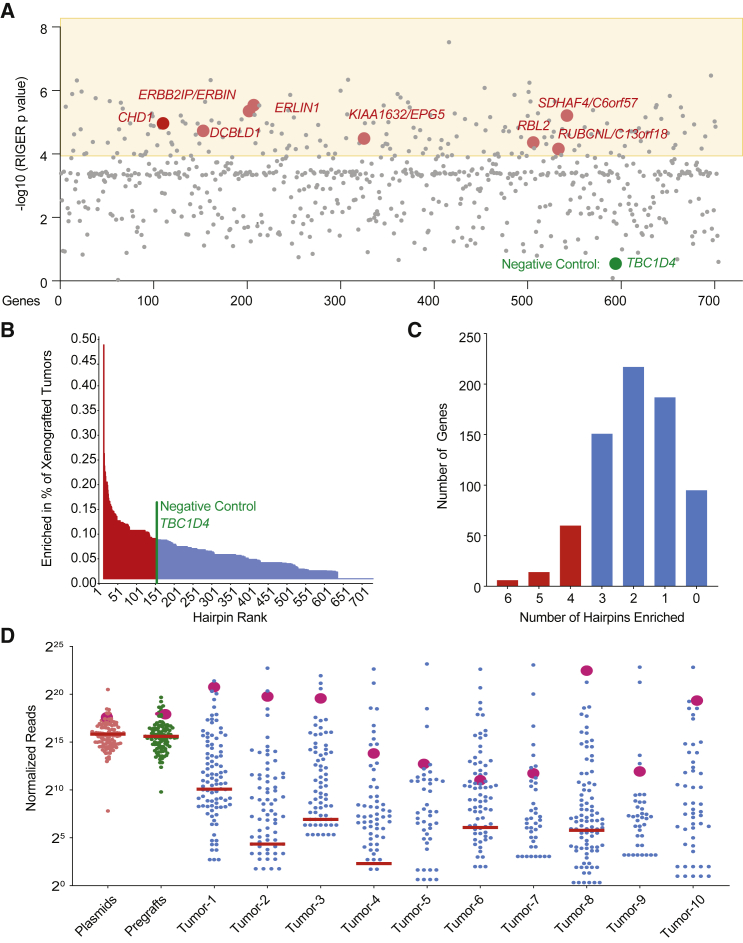
In Vivo Screen Identifies CHD1 as Top Candidate Responsible for Resistance to Antiandrogen(A) Graphical representation of analyzed results of the library screen, using RIGER-E method. –Log10 of p value is presented and the area of p < 0.0001 is highlighted. The top eight candidate genes are presented as large red dots with gene symbol. Negative control gene TBC1D4 is presented as a large green dot.(B) Graphical representation of the percentage of tumors which have shRNAs targeting a specific gene and are enriched in resistant tumors.(C) Graphical representation of the number of genes which have multiple independent shRNAs enriched in resistant tumors.(D) Bee swarm plot of the normalized shRNA read counts of a representative pool in the plasmid, pregraft, and resistant tumors, median is presented as a red line (medians below 1 are not presented on log2 scale). shCHD1s are presented as large red dots.See also Table S3.